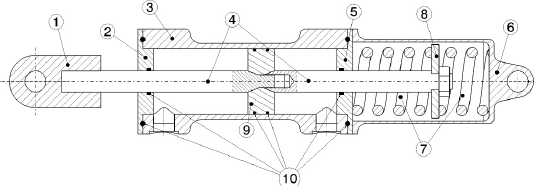
Figure 8. Details of the shock-absorber: (1) eyelet on the moving rod; (2) upper head; (3) body of the shock-absorber; (4) rods; (5) lower head; (6) compartment of the spring; (7) springs; (8) plate for interaction rod-springs; (9) piston; (10) seals.